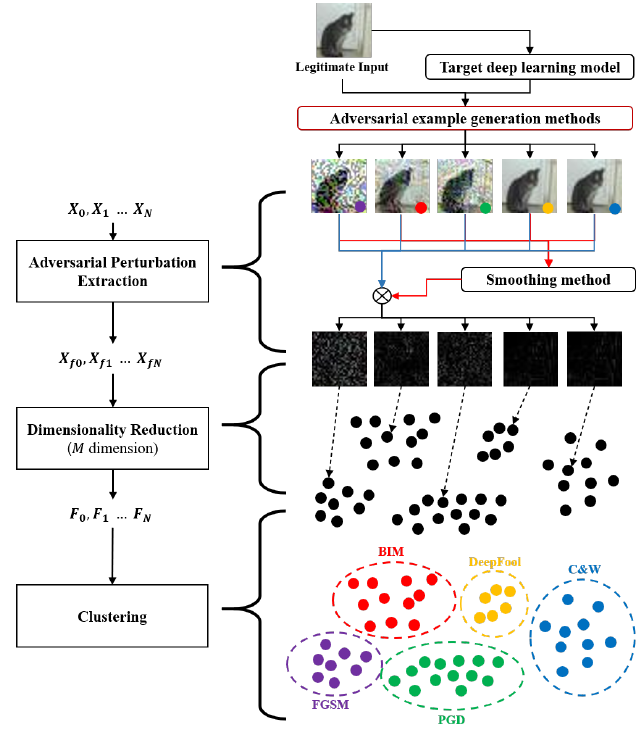
Figure 2. Overall operation of the proposed